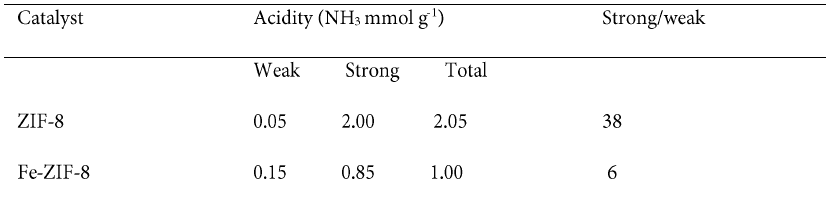
Table 2. Acidity and strong/weak